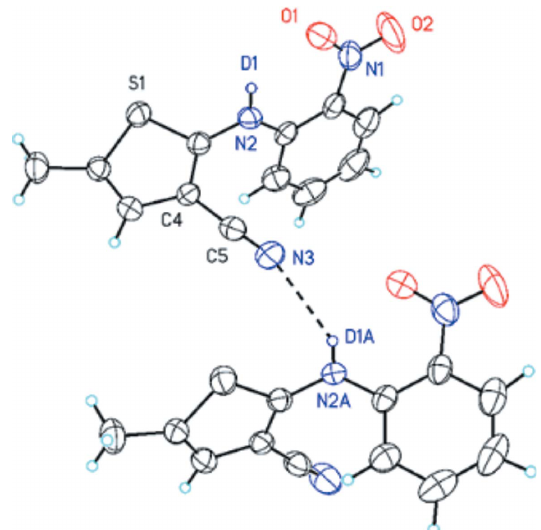
Figure 3 Molecular aggregation of the Y form of d 1 -ROY and the intermolecular hydrogen bond N—D (cid:6)(cid:6)(cid:6) NC (2.288 A˚ ).